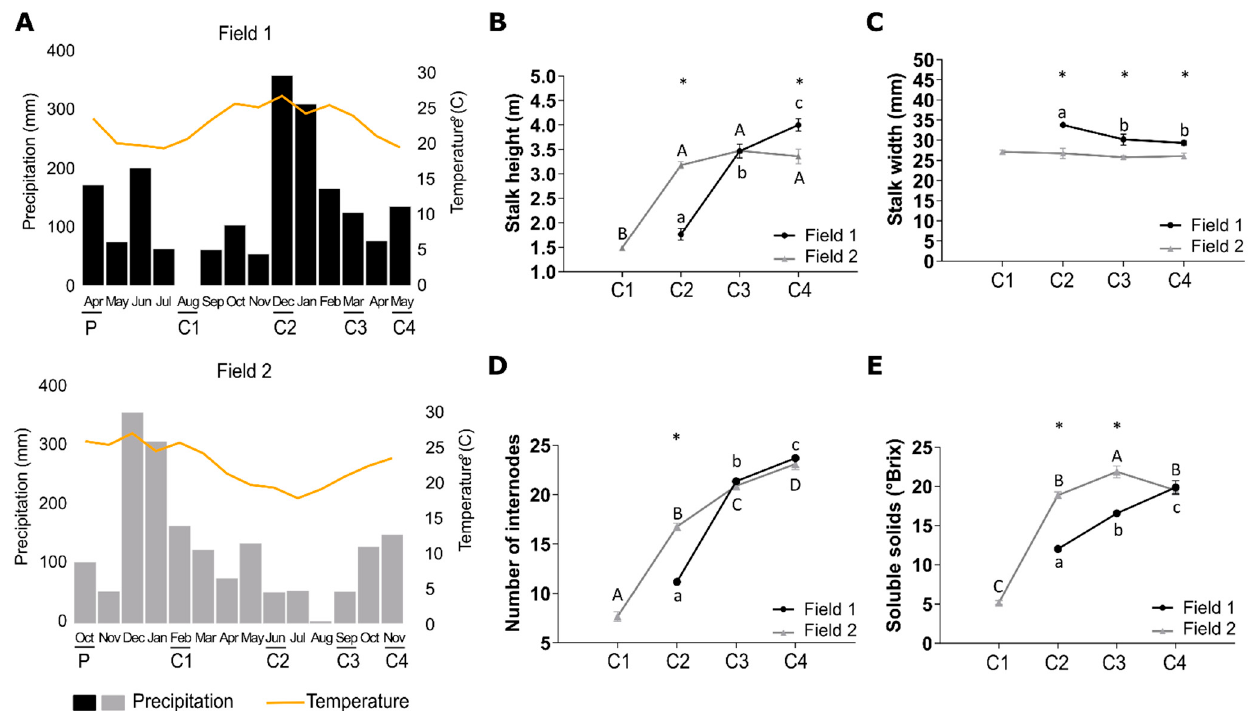
Figure 2. Precipitation and temperature during the initial months after sugarcane planting affect initial sugarcane elongation and stalk height, width, and soluble solids content at the stage of ripening. ( A ) Precipitation and temperature measures of fields 1 (F1) and 2 (F2). ( B ) Stalk-height, ( C ) stalk width, ( D ) number of internodes, and ( E ) soluble solids content in F1 and F2 in 4 (C1), 8 (C2), 11 (C3), and 13 (C4)-month-old plants. Letters and * are from the split2.crd results. Means with the same letter are not significantly different and means with different letters are significantly different between collection points. * shows differences between F1 and F2. Error bars show the standard error of the mean.